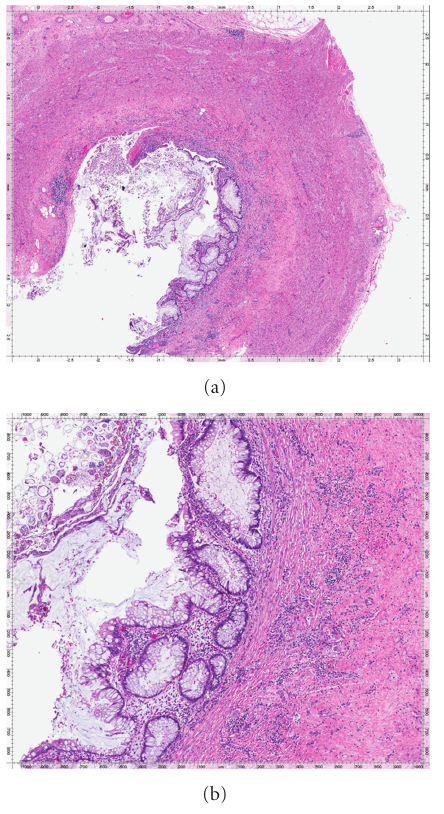
Figure 5: (a) Histological image of the appendiceal specimen in Case 2. (b) Histological image at higher magnification demon- strating adenomatous changes at crypt bases with abundant mucin which is characteristic of appendiceal